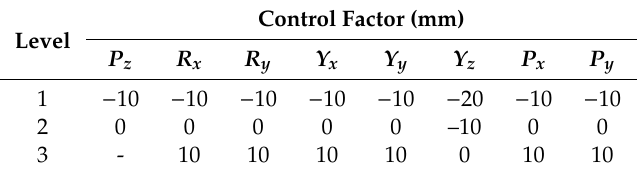
Table 1. Levels of control factors for the first experimental set.